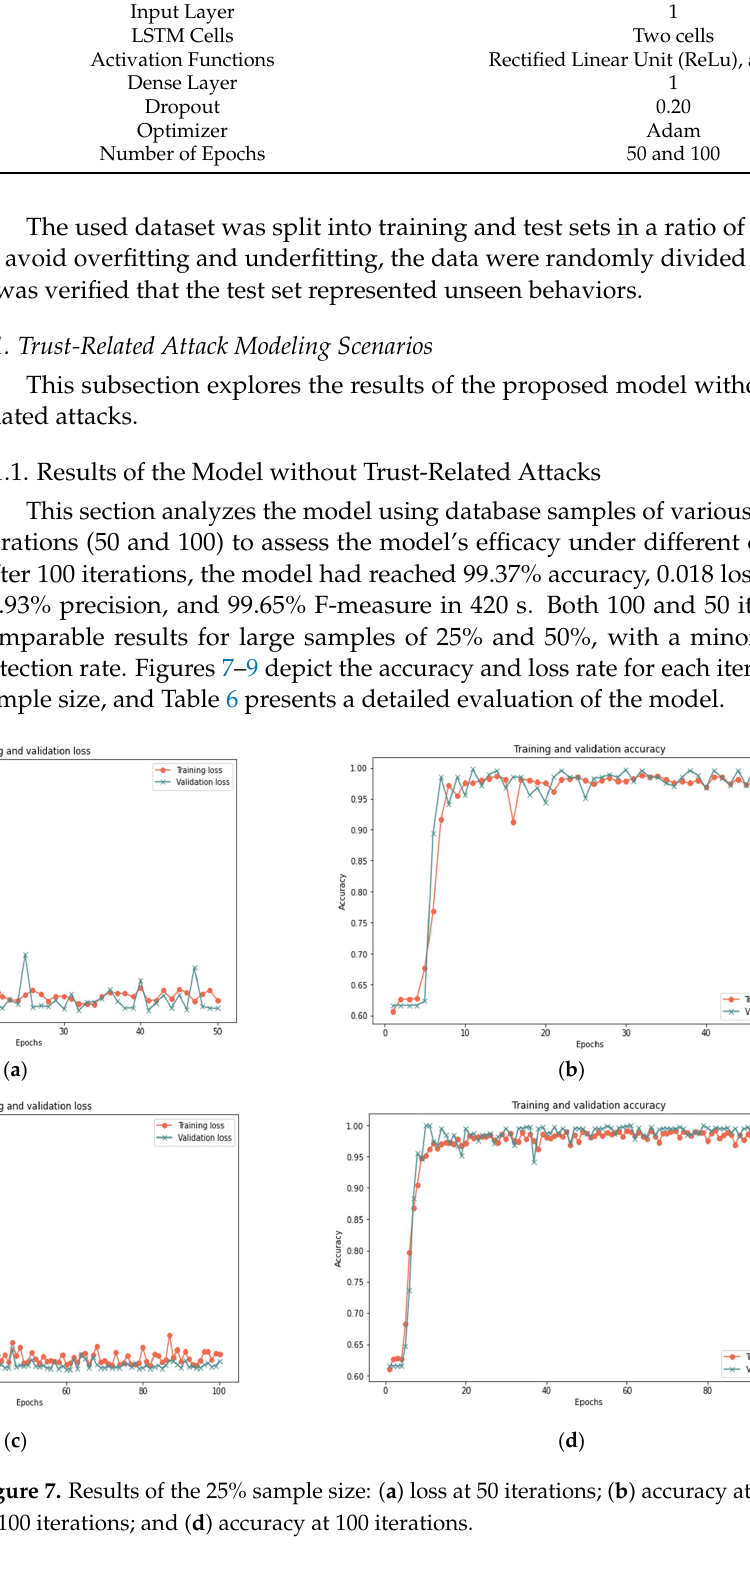
Table 5. Model setup.